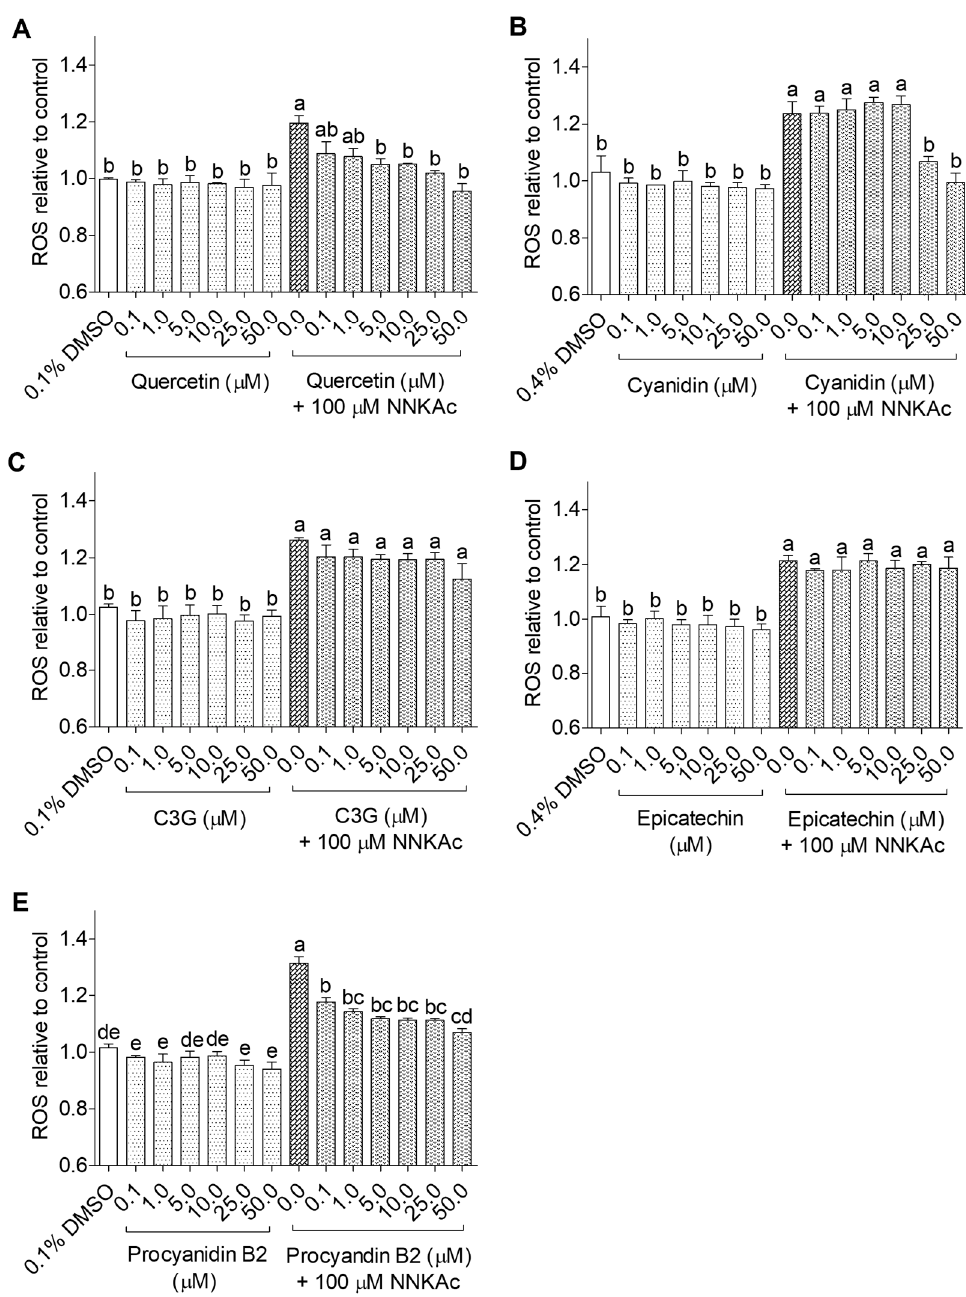
Figure 1. Effect of quercetin ( A ), cyanidin ( B ), cyanidin-3- O -glucoside ( C ), epicatechin ( D ), and procyanidin B2 ( E ) on reducing NNKAc-induced ROS in BEAS-2B cells. Cells were pre-treated with concentrations ranging from 0.1 to 50 µM of 3-hydroxy flavonoids for 3 h. Pre-treated cells were exposed to 100 µM NNKAc for another 3 h to induce ROS generation. DMSO (0.1 or 0.4%) was used as the vehicle control. Effects on ROS levels were quantified using DCFDA fluorescence assay. Two independent studies ( n = 3) were performed, and results were expressed as mean ± standard deviation. Statistical analysis of data was performed by one-way ANOVA and mean comparison was done by Tukey’s mean comparison method ( α = 0.05) using Minitab 19 statistical software (LLC, Pennsylvania, USA). Mean values that do not share similar letters in bar graphs are significantly different ( p < 0.05). Abbreviations: NNKAc: 4-[(acetoxymethyl)nitrosamino]-1-(3-pyridyl)-1-butanone, ROS: reactive oxygen species, DCFDA: 2 (cid:48) 7 (cid:48) -dichlorofluorescein diacetate, DMSO: dimethylsulfoxide, C3G: cyanidin-3- O